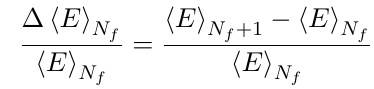
Figure 8. Behaviour of the different t 2 h E i see (5.3). From top to bottom: the YM (solid purple), the NM (dashed red), and the sNM (blue dot-dashed) gradient flow cases. The horizontal gray dotted line is there to better visualize the relative